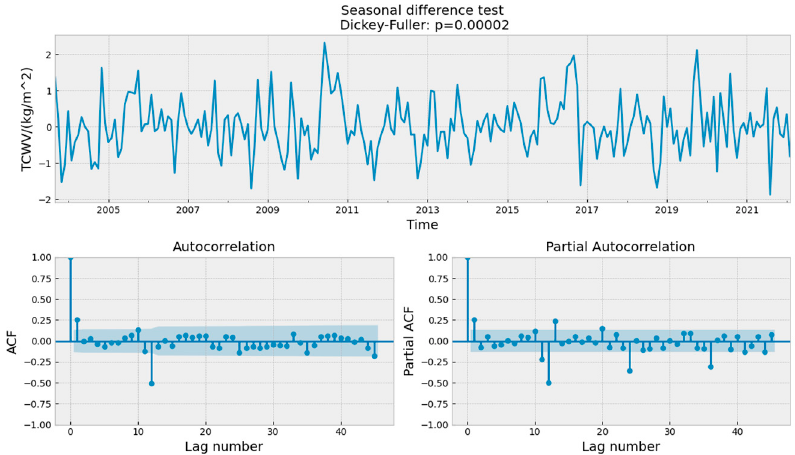
Figure 8. Time series, autocorrelation and partial autocorrelation of TCWV after seasonal difference.